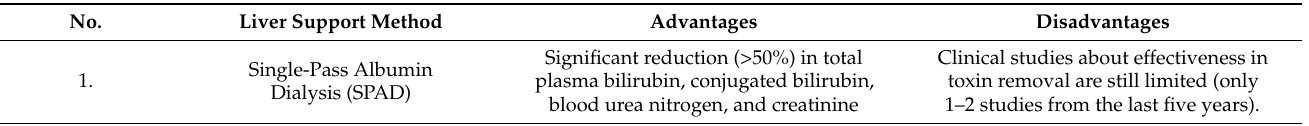
Table 1. Advantages and Disadvantages of Each Liver Support-System Method.